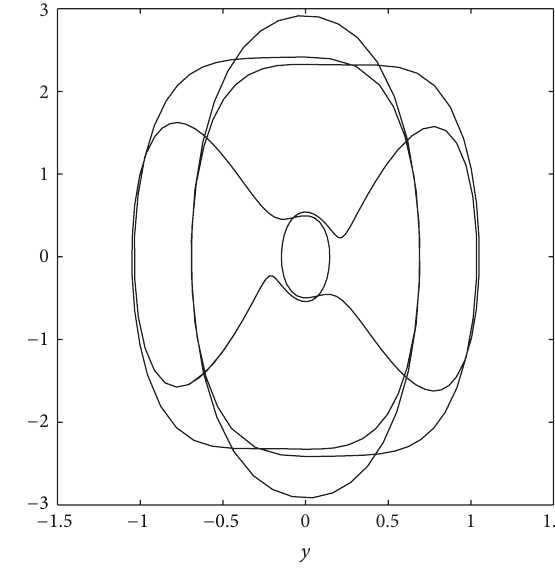
Figure 8: Phase portrait (𝑦, ̇𝑦)